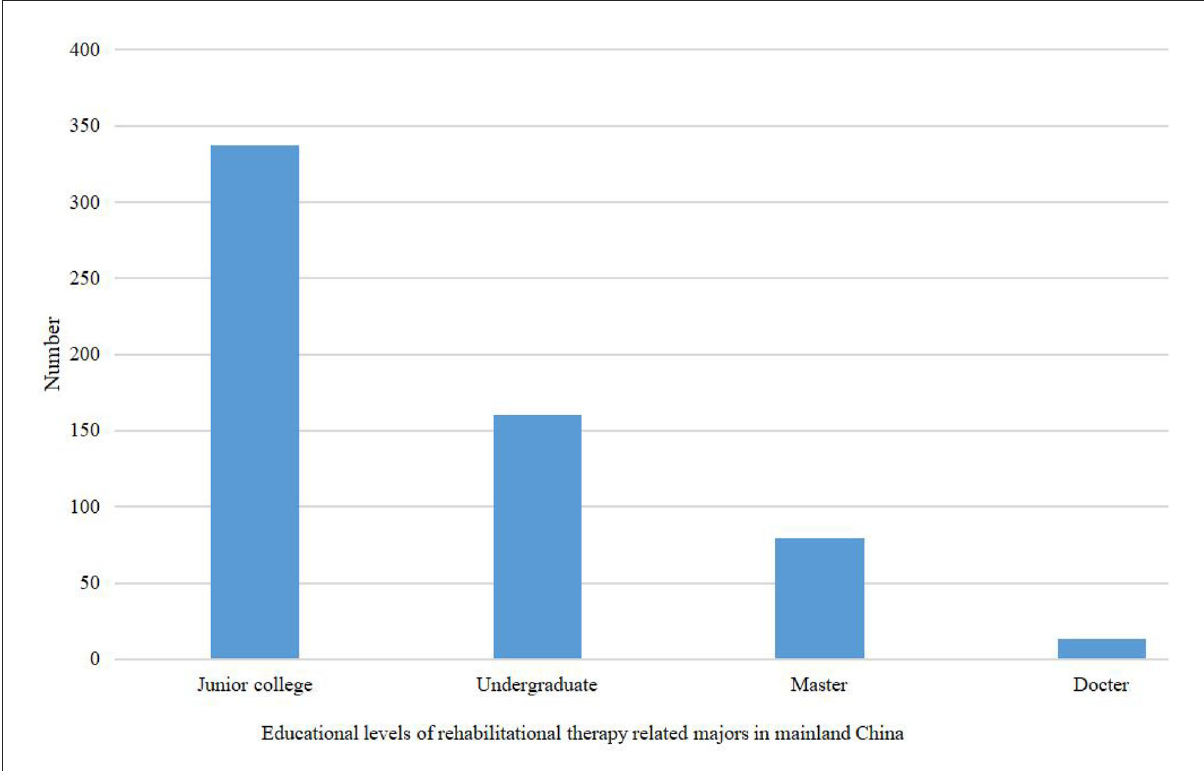
FIGURE1 Number of colleges and universities at various levels of education in rehabilitation therapy-related majors in China (according to incomplete statistics by